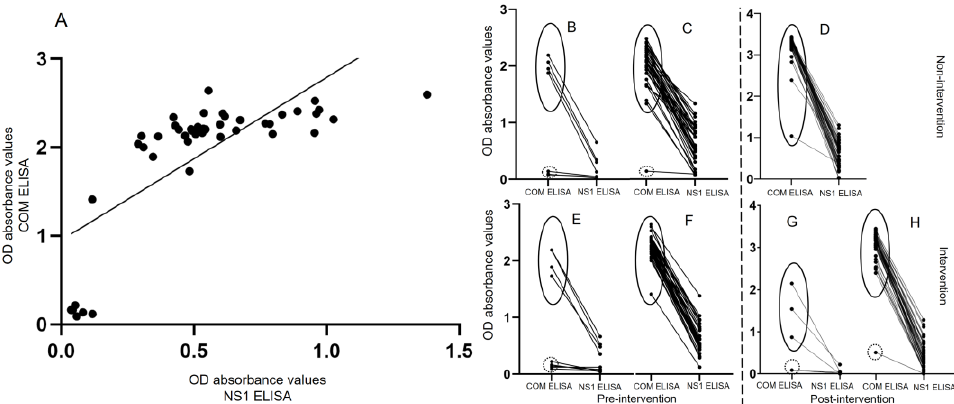
Figure 4. The comparison of the OD absorbance values obtained with the COM ELISA and NS1 ELISA as correlation coefficient measurement for serum samples collected in October 2017 (pre-intervention) and in February 2020 (post-intervention) at the non-intervention ( n = 45; n = 47) and intervention ( n = 45; n = 47) sites, respectively. ( A ) shows correlation OD absorbance values between the COM ELISA